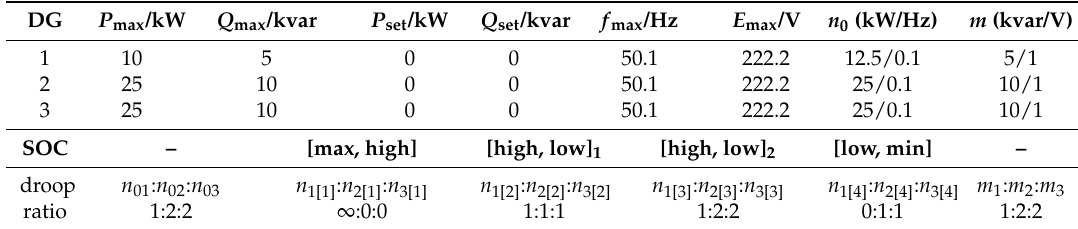
Table 1. Parameters of P-f and Q-U droop